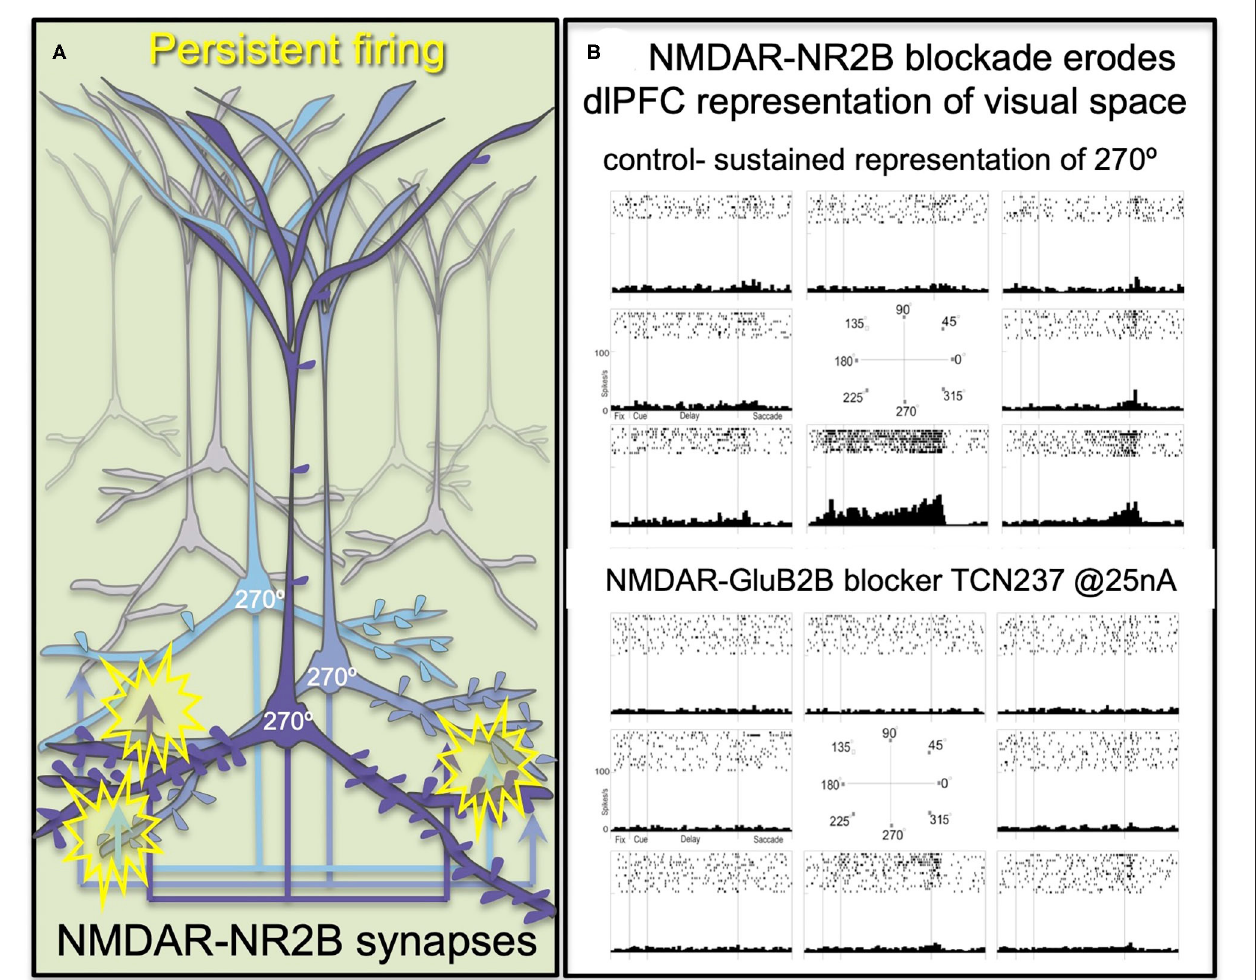
FIGURE 2 | The persistent firing of dlPFC Delay cells depends on NMDAR with GluN2B subunits. (A) Schematic illustration of the recurrent excitatory microcircuits in deep layer III of dlPFC that generate persistent firing. (B) A dlPFC Delay cell that represents the spatial position of 270 ◦ during a spatial working memory task, maintaining firing across the delay period for only that preferred location. Iontophoresis of the selective NMDAR- GluN2B antagonist, TCN237, completely blocks the ability of the neuron to generate representations of visual space.